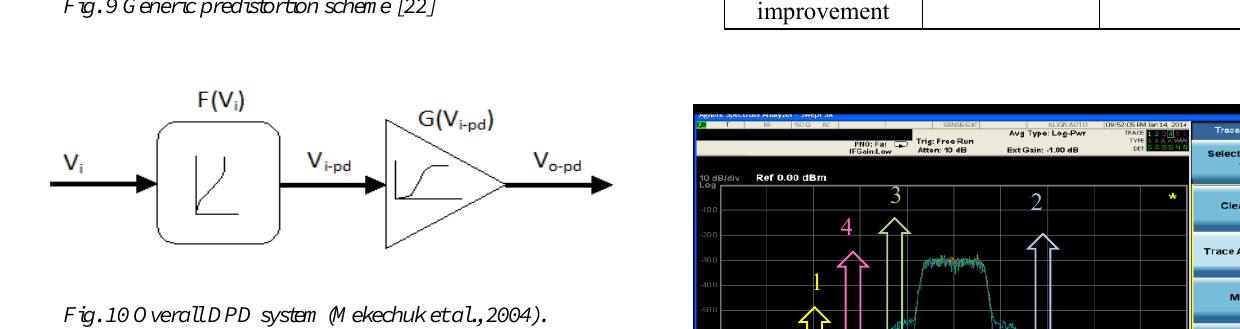
Fig. 9 Generic predistortion scheme [22]